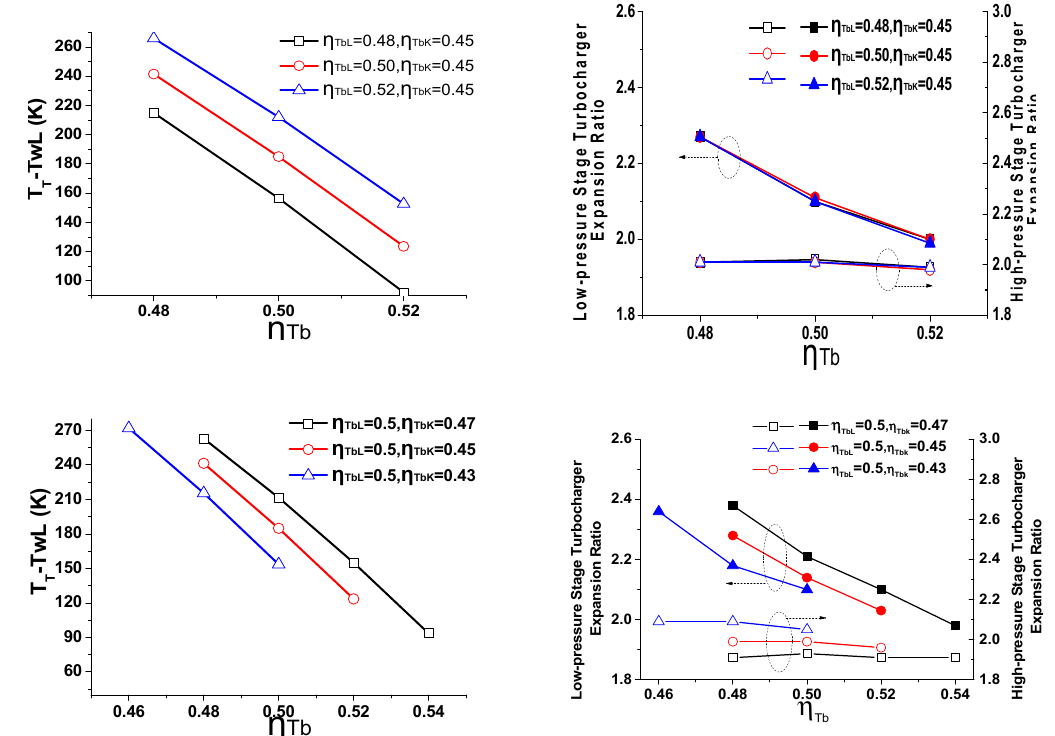
Figure 8. Relationship between the total turbocharger e ffi ciency, the front–rear temperature di ff erence of the high-pressure stage turbine T T - T WL , and the expansion ratio at each